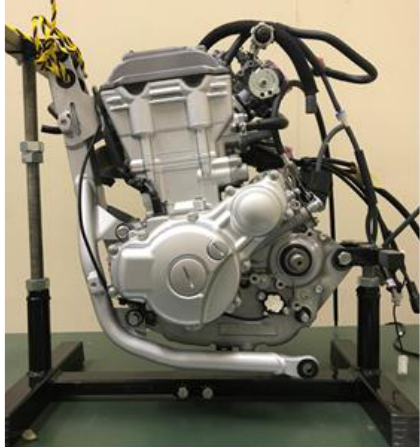
Figure 5. ICE of G363E manufactured by Yamaha Motor Co., Ltd., Iwata, Japan. Table 1. Specifications of the ICE.